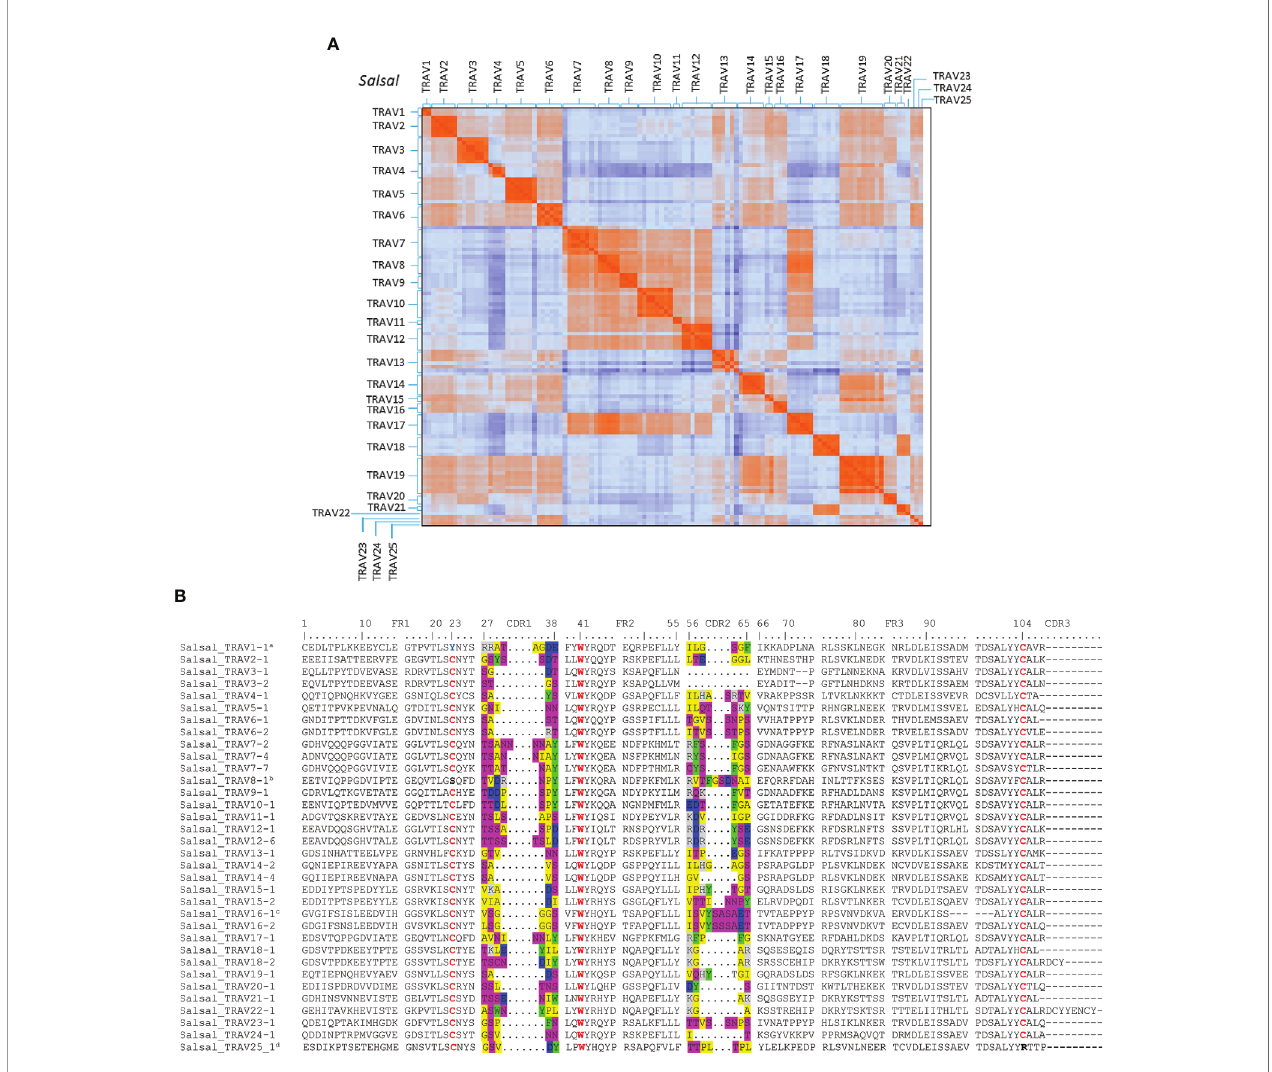
FIGURE 4 | Comparison of TRAV sequences from Atlantic salmon. (A) Heatmap representation of pairwise distance matrix of functional and ORF TRAV. Pairwise distances were estimated from amino acid alignments using the Poisson model. 103 functional TRAV and 12 ORF (TRAV4-2, TRAV4-4, TRAV5-7, TRAV6-3, TRAV7- 1, TRAV8-5, TRAV10-3, TRAV10-5, TRAV12-3, TRAV13-4, TRAV13-6 and TRAV14-1) were included in the analysis. Co l or in each pixel indicate pairwise distance among and between each TRAV sequence. (B) Multiple Alignment of representative TRAV subgroups for Atlantic salmon ( ‘ Salsal ’ in the IMGT 6-letter abbreviation for genus and species). The CDR1 and CDR2 encoded amino acids are colored as follows: gray positively charged R groups, blue negatively charged R groups, green aromatic R groups, pink polar uncharged R groups, yellow nonpolar R groups, red conserved cysteines (1st-CYS 23 and 2nd-CYS 104) and conserved tryptophan 41. a Conserved 1st-CYS 23 is replaced by a Tyrosine (Y). b Conserved 1st-CYS 23 is replaced by a Serine (S). c six amino-acid deletion in FR3 compared to the other genes of the subgroup. d Conserved 2nd-CYS 104 is replaced by a